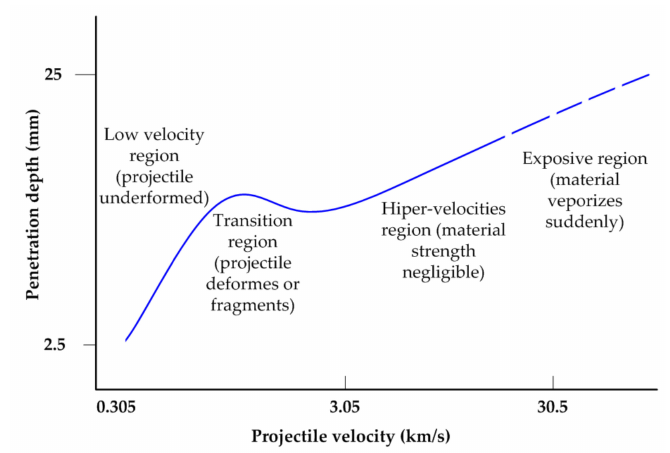
Figure 7. Variation of depth of projectile penetration with projectile velocity